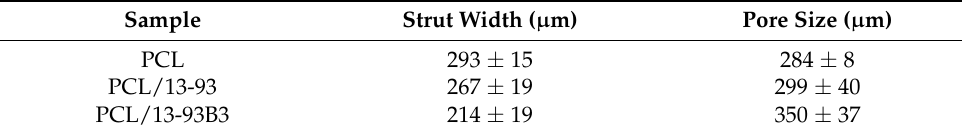
Table 3. Porosity values of PCL and PCL/BG composite scaffolds before and after coating.